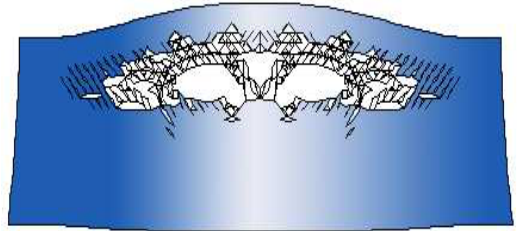
σ − , A − ] after shockwave load at t = 20 Fig. 1. Steel sample [ k k µs. Figure reprinted from [3]. Calculations were obtained using a computer program developed by Yuri